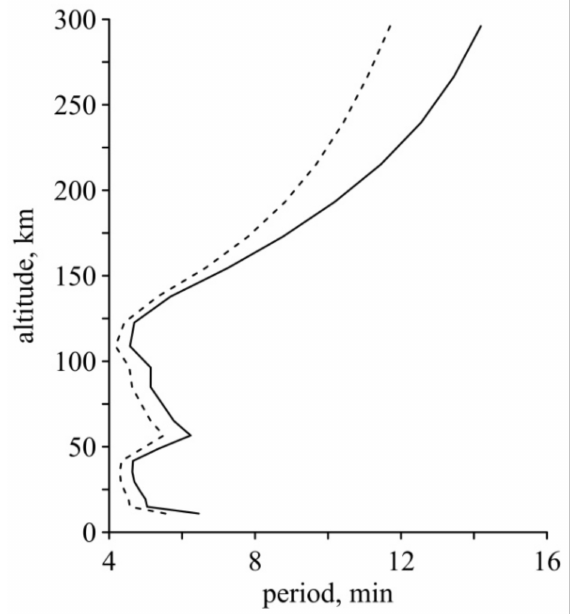
Figure 2. Vertical profiles of the periods of waves propagating in the atmosphere, calculated using data from [38]. The solid line corresponds to the wave with Brunt–Vaisala frequency, and the dotted line corresponds to the wave with acoustic cutoff